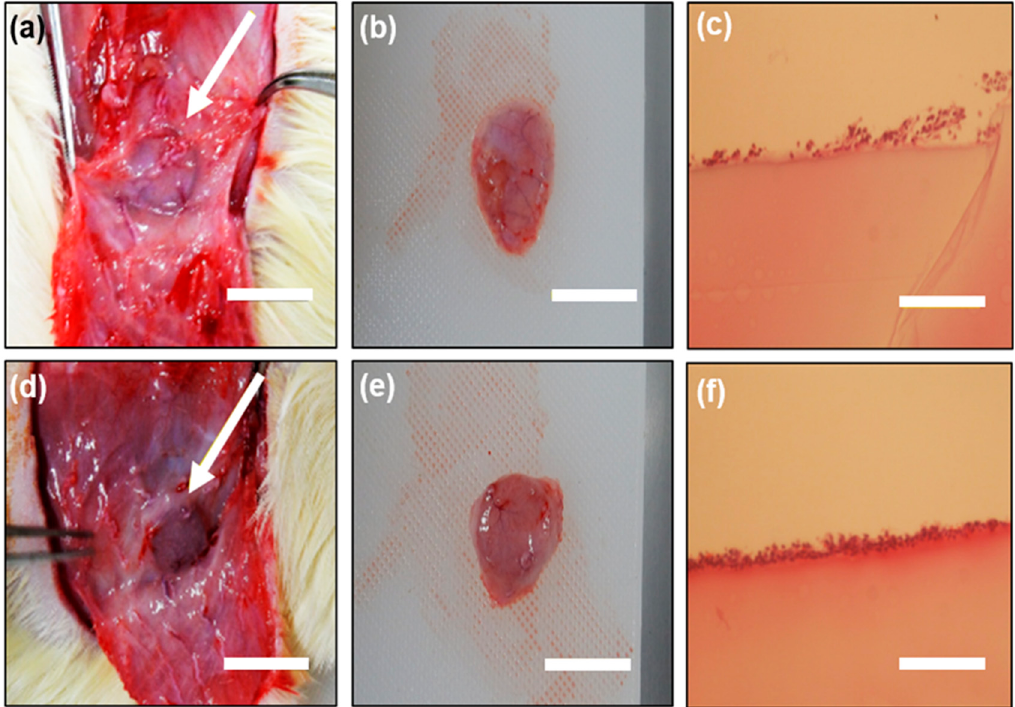
Figure 7. ABA-free gelatin gel: ( a ) 1 week after transplantation; ( b ) after the extraction of the gel and ( c ) hematoxylin and eosin (H&E) staining of the gel after subcutaneous implantation for 1 week in the rat; ABA-immobilized gelatin gel: ( d ) 1 week after transplantation; ( e ) after the extraction of the gel and ( f ) H&E staining of the gel after subcutaneous implantation for 1 week in the rat. Bars represent 1 cm and the arrows indicate the gel sample.